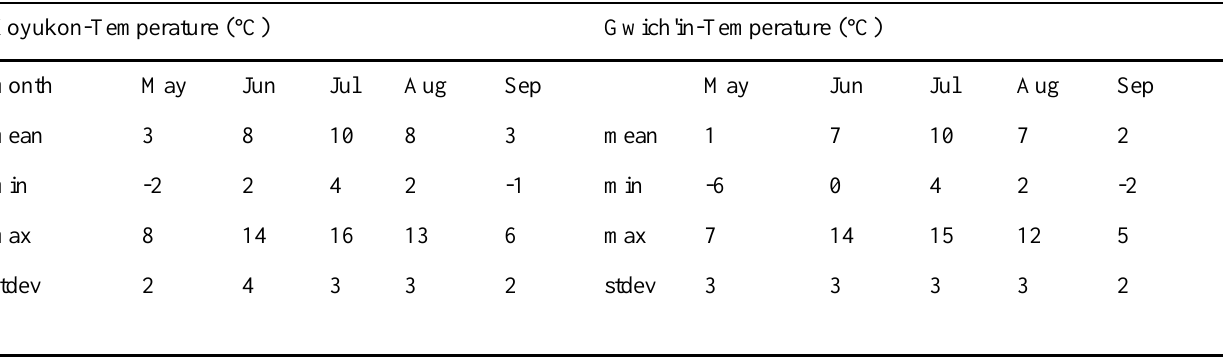
Table 2. Mean monthly temperature (1901–1930) comparison of Koyukon and Gwich’in territories in